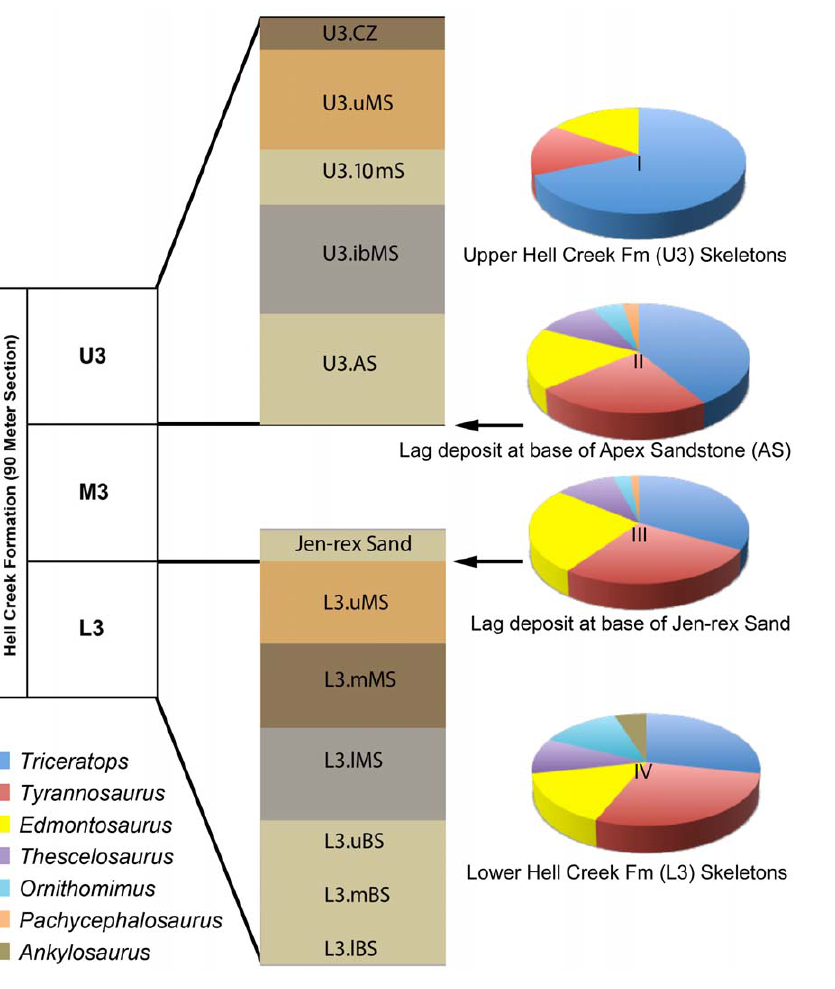
Figure 2. Stratigraphic divisions of the Hell Creek Formation with stratigraphic details of the upper third (U3) and lower third (L3) sequences referenced in the text and the associated pie chart showing dinosaur abundance. Pie charts I – IV reflect the relative abundance of dinosaur genera based on skeletons (charts I and IV) and individual bones (charts II and III). Tyrannosaurus skeletons are as abundant as the hadrosaurid Edmontosaurus , an herbivore, in the upper Hell Creek Formation and nearly twice as common as Edmontosaurus in the lower Hell Creek Formation. Individual bones of Tyrannosaurus and Edmontosaurus are found approximately in the same order of magnitude within the lag deposits. Key: Pie chart I , dinosaur skeletons in the upper Hell Creek Formation (U3); Pie chart II , dinosaur bones from the ‘‘Doldrum’s’’ lag deposit at the base of the Apex Sandstone (AS); Pie chart III , dinosaur bones from the ‘‘3B-1’’ lag deposit at the base of the Jen-rex Sand; and Pie chart IV , dinosaur skeletons from the lower Hell Creek Formation (L3). Abbreviations: L3lBS , lower basal sandstone; L3.mBS , middle basal sandstone; L3.uBS , upper basal sandstone; L3.lMS , lower mudstone; L3.mMS , middle mudstone; L3.uMS , upper mudstone; U3.AS , Apex sandstone; U3.ibMS , interbedded mudstone; U3.10mS , 10 meter sandstone; U3.uMS , upper mudstone; U3.CZ , coal zone.